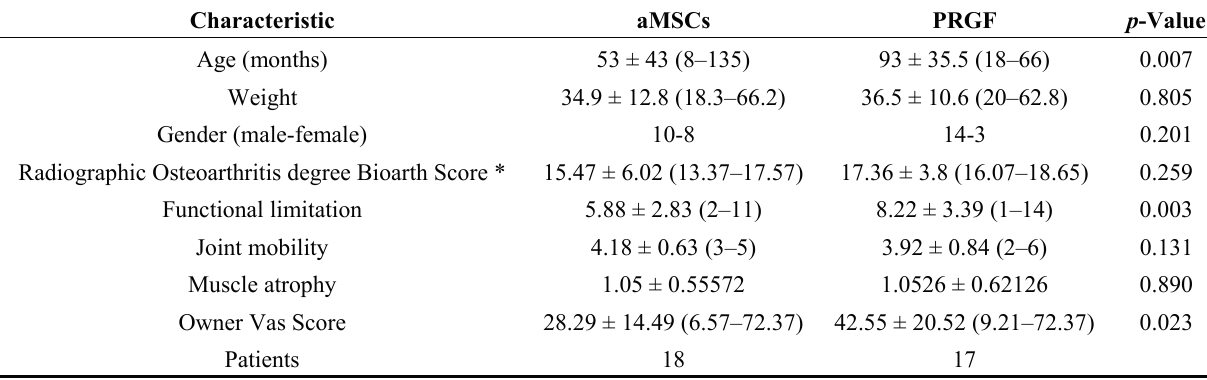
Table 1. Baseline characteristics of patients